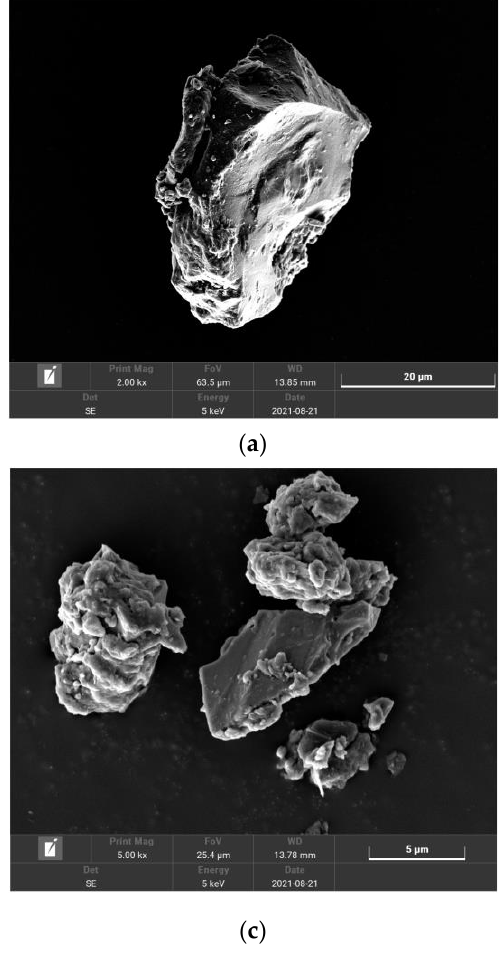
Figure 2. SEM diagram of cement and coral powder. ( a ) Cement. ( b ) Fine coral powder. ( c ) Coarse coral powder.